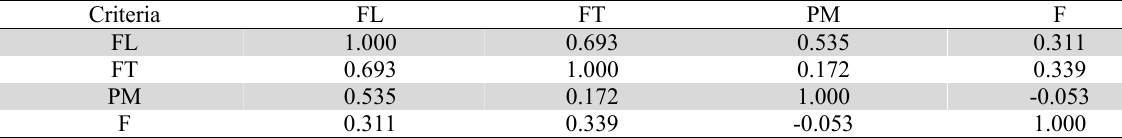
Correlation coefficient values for Example 5